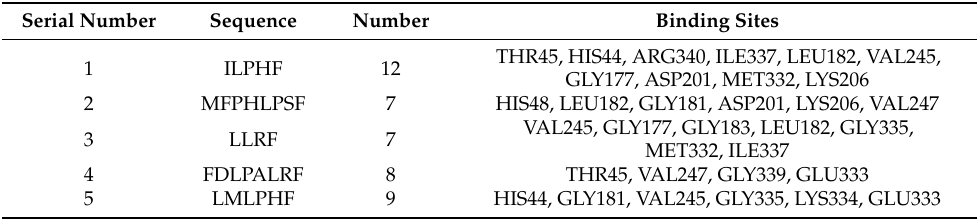
Table 2. Number of hydrogen bonds and binding sites from peptides.